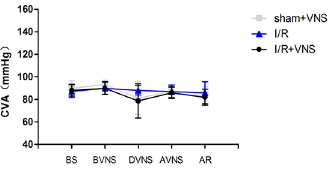
Figure 2. Time course of CVA during the experiment. Changes in tail arterial pressure are shown for the three groups during the experiment. The time points are as follows: baseline (BS), after occlusion but before stimulation (BVNS), during the stimulation (DVNS), after stimulation but before reperfusion (AVNS), and after reperfusion (AR). * p , 0.05 relative to the time point (BVNS). # p , 0.05 relative to the time point (AVNS).